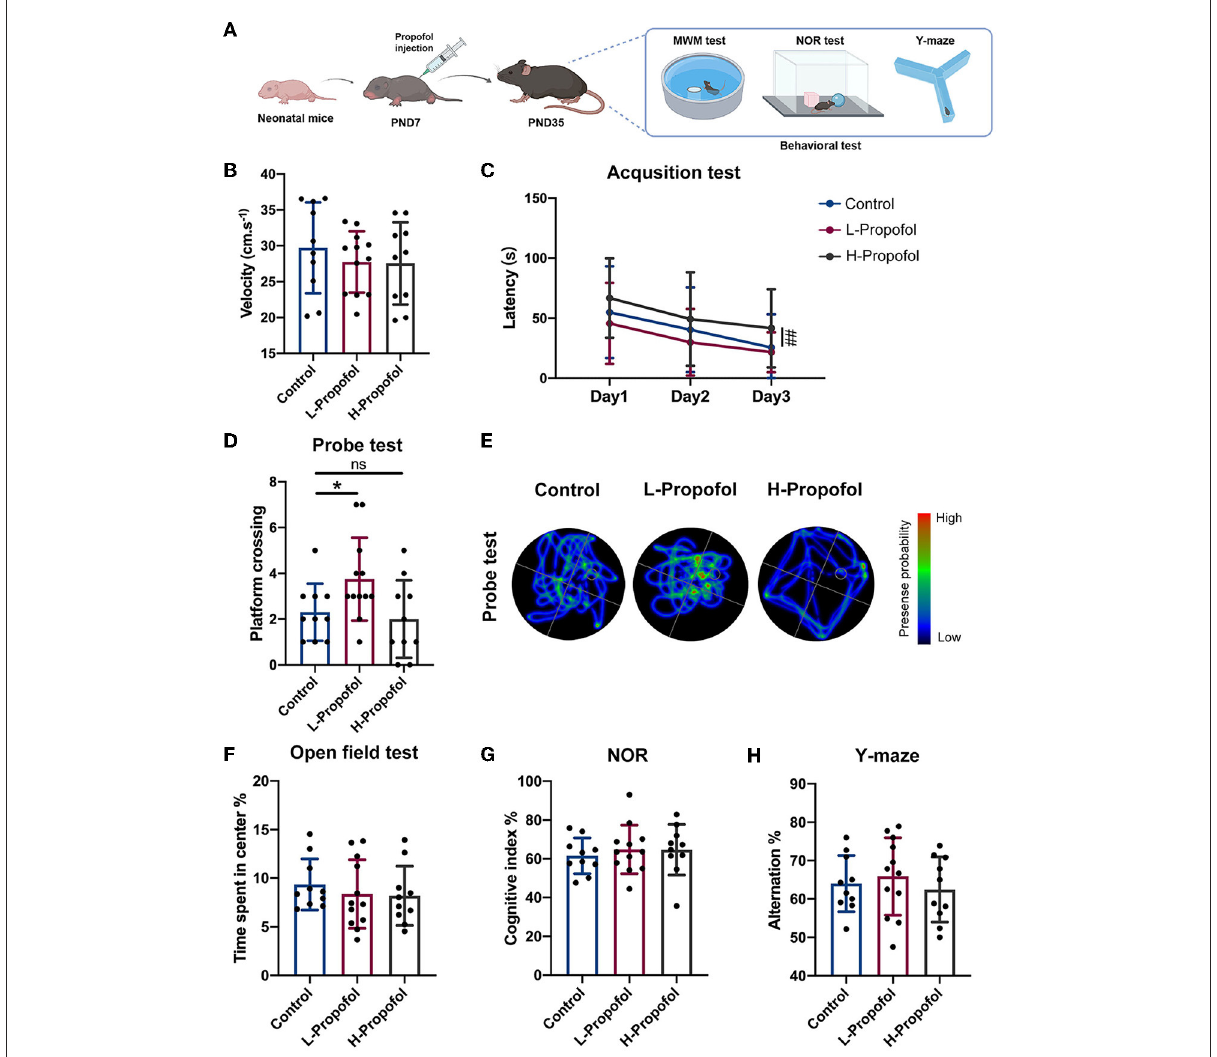
FIGURE1 Early low-dose Propofol administration promoted spatial cognitive ability in mice. (A) Workflow of Propofol treatment and behavior tests in C57BL/6N. (B) Velocity of mice among groups showing similarity on day 1 of acquisition test. (C) Acquisition test showing a trend that L-Propofol mice spent less time on the hidden platform compared with the Control group, while H-Propofol mice exhibited increased escape latency (H-Propofol vs. Control: p = 0.009) relative to the other two groups during day 1–3. (D) Platform crossing in probe test showing that L-Propofol mice significantly increased the number of platform crossing (L-Propofol vs. Control: p = 0.046). (E) Typical swimming path in the probe test. (F) Time spend exploring the center in OFT. (G) The cognitive index in NOR. (H) The percentage of spontaneous alternation in Y-maze. Three groups performed similarly in OFT, NOR, and Y-maze. N = 10 (Control), 12 (L-Propofol), 10 (H-Propofol). Error bars means ± SD. * (L-Propofol vs Control), p < 0.05; ## (H-Propofol vs Control), p < 0.01, ns, no significant. One-way repeated measures ANOVA, one-way ANOVA, and LSD test for multiple comparisons were used for